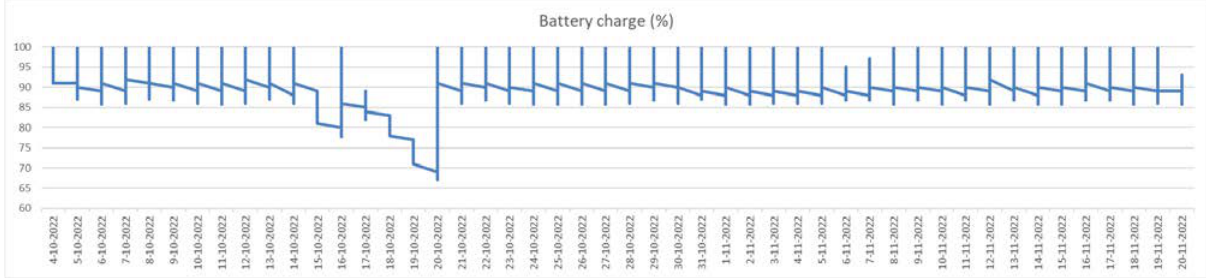
Figure 5. Cross correlation heatmap of all sensory inputs. TVOC and CO 2 show high correlation and humidity and temperature strong anti-correlation. In and out counts are highly correlated.